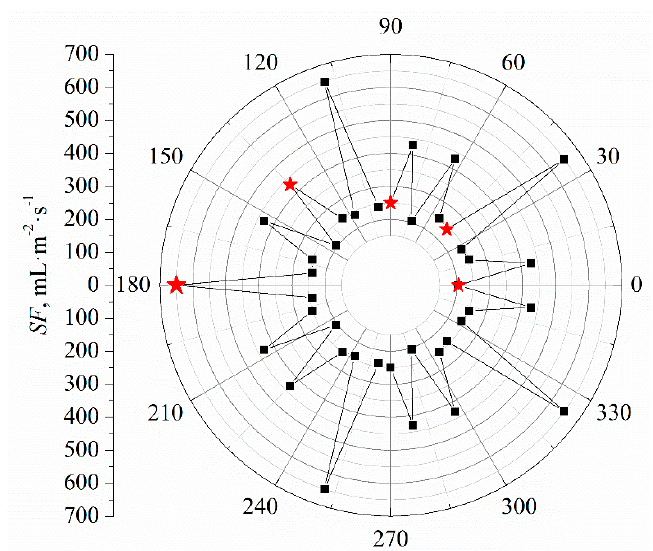
Figure 5. SF on the furnace inner wall at the height of 192.0 mm above bath surface ( L = 160.0 mm, Q = 36.4 Nm 3 ·h − 1 ). “ ★ ” experimental data, and “ ■ ”data obtained by symmetry analysis.